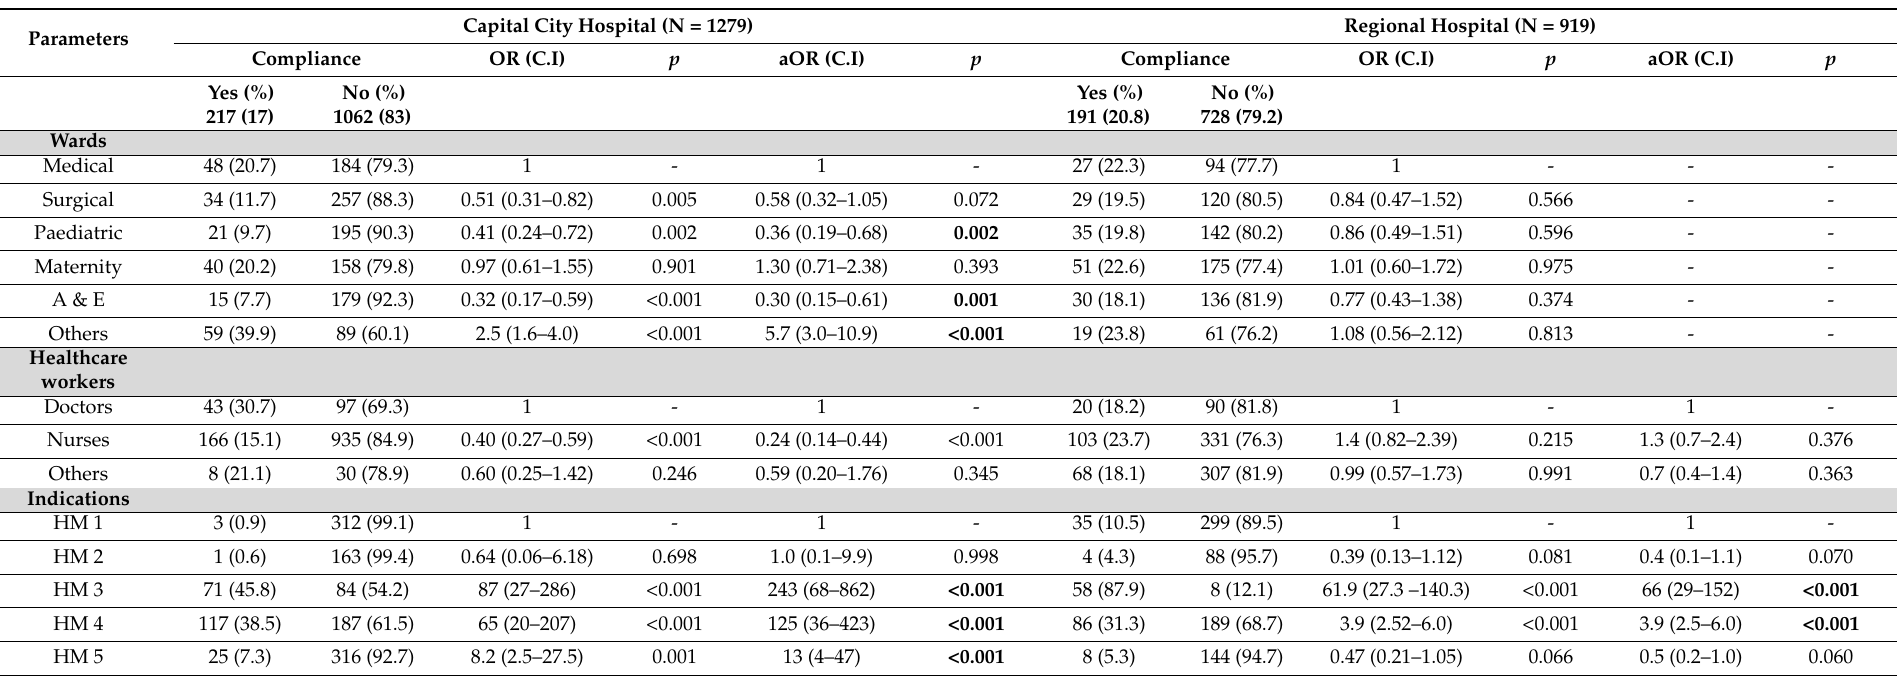
Table 5. Hand hygiene compliance by wards, healthcare workers and indicators in the two